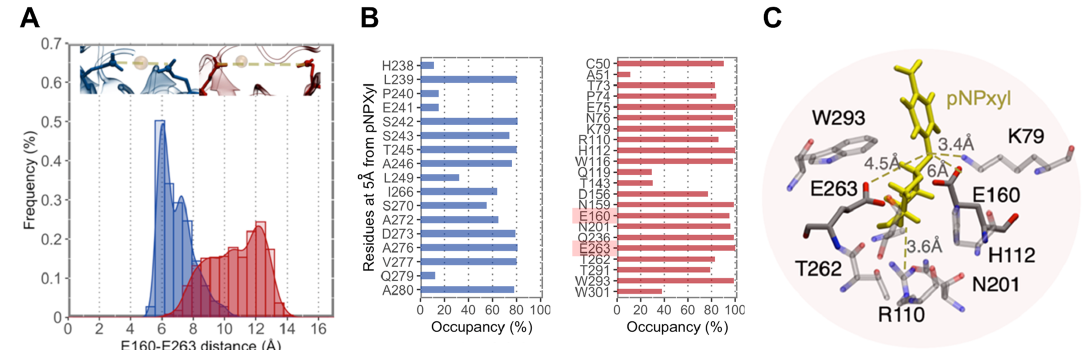
Figure 4. ( A ) Distribution of distances between E160 and E263 in XynA (blue) and XynA Δ 29 (red) measured during a trajectory of 1 µs. ( B ) Frequency of residue occupancy of XynA (blue) and XynA Δ 29 (red) by pNPXyl during the same trajectory. In XynA the substrate visits residues outside the active site, while in XynA Δ 29 the substrate interacts with amino acids of the active site, in- cluding E160 and E263 (highlighted). ( C ) Interactions of pNPXyl (yellow) with relevant amino ac- ids of the active site of XynA Δ 29, including catalytic residues E160 and E263.